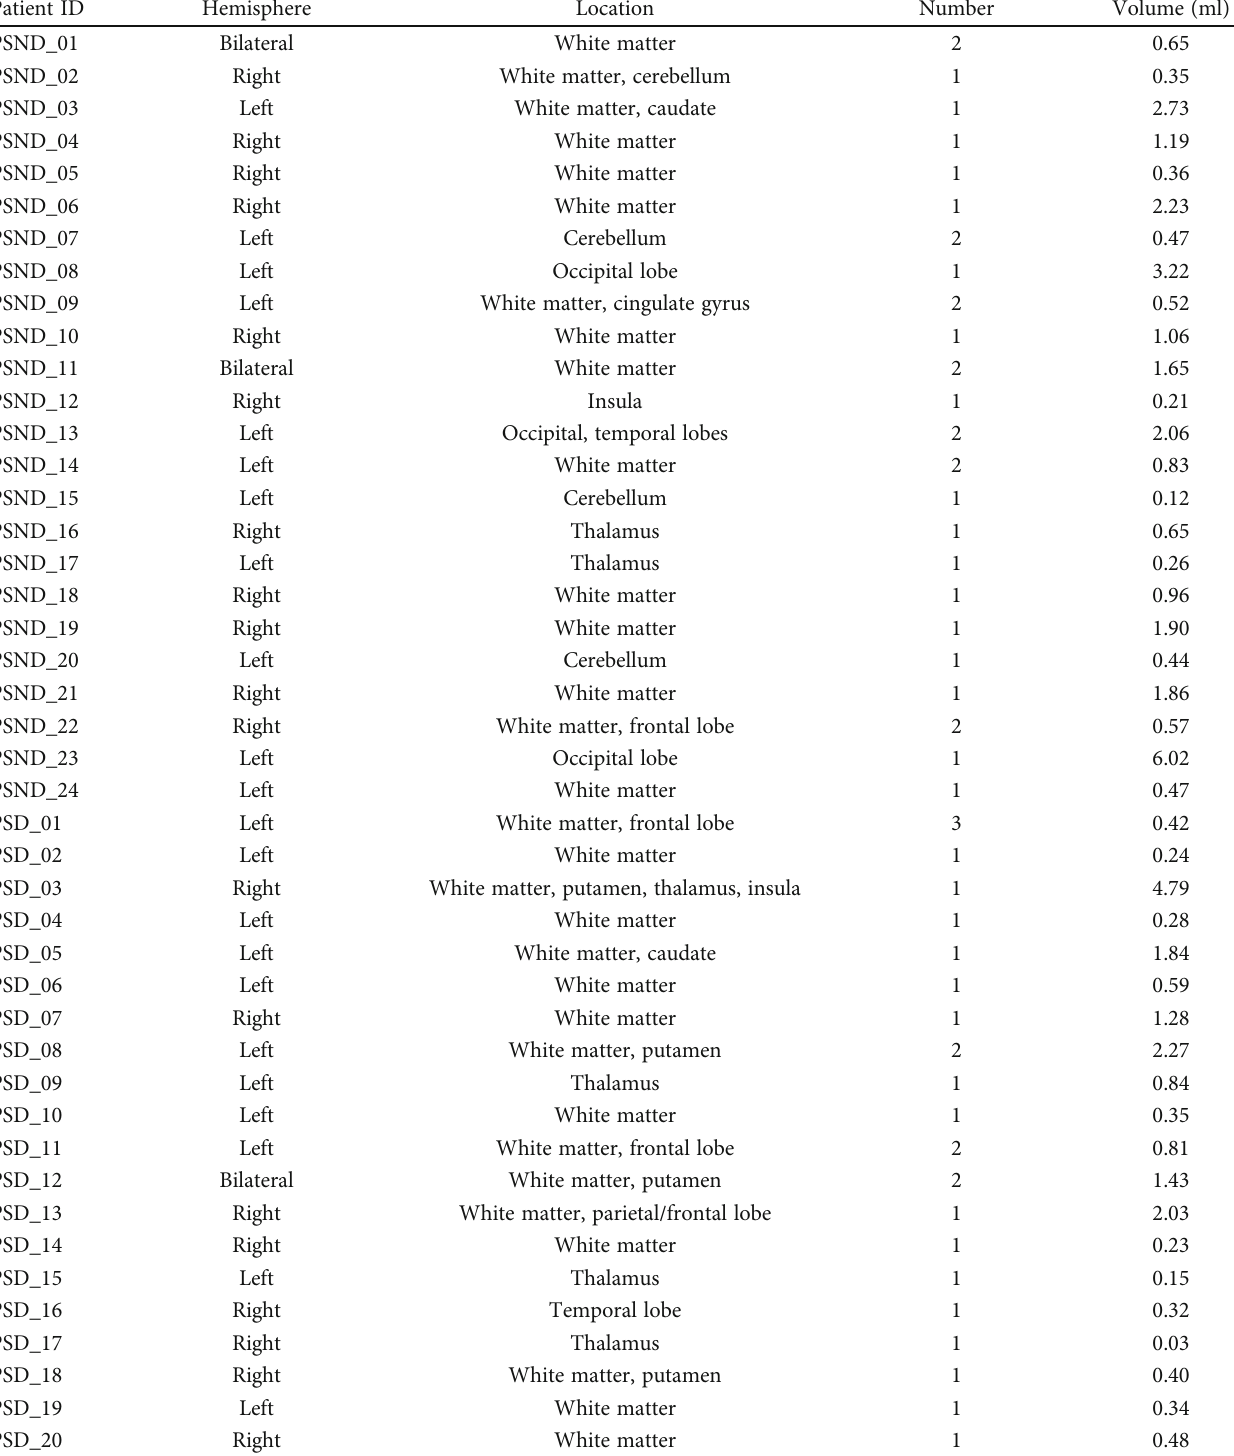
Table 3: The information of stroke lesions in